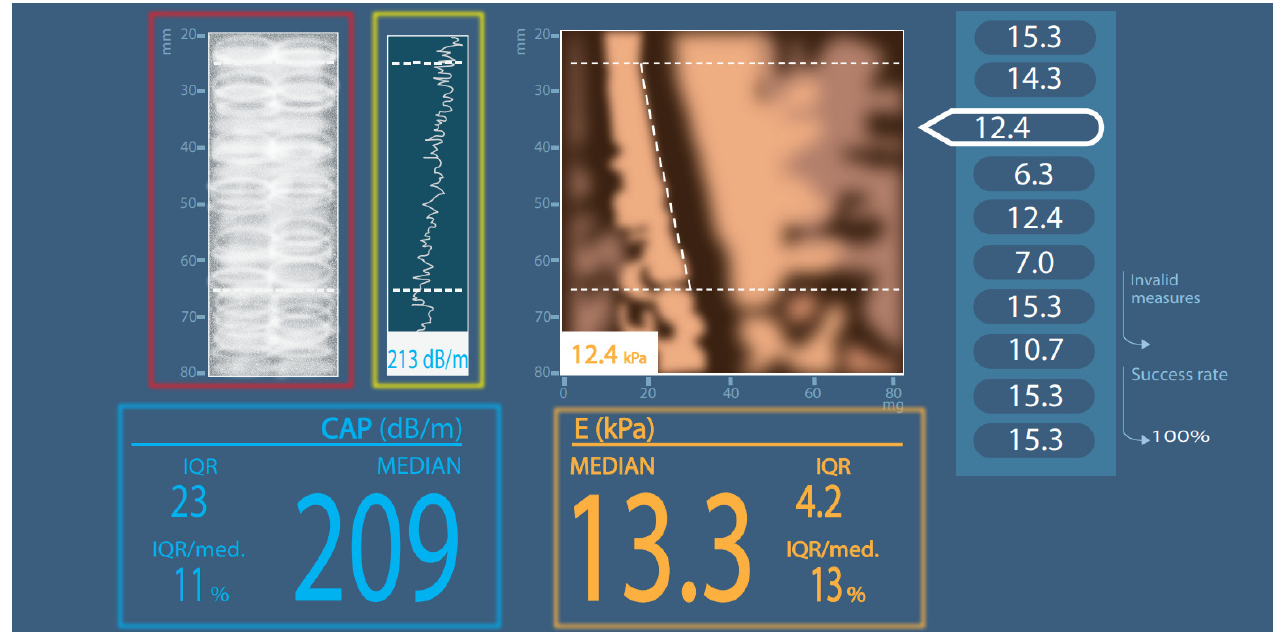
Figure 1. Simplified CAP measurement scheme. Red square: A-mode ultrasound picture; green square: internal liver tissue identification; blue square: CAP result; orange square: elastography result; CAP—controlled attenuation parameter; IQR—interquartile range; dB/m—decibels per meter; E—elastography; kPa—kilopascals; MEDIAN or med.—median value; mm—millimeters.